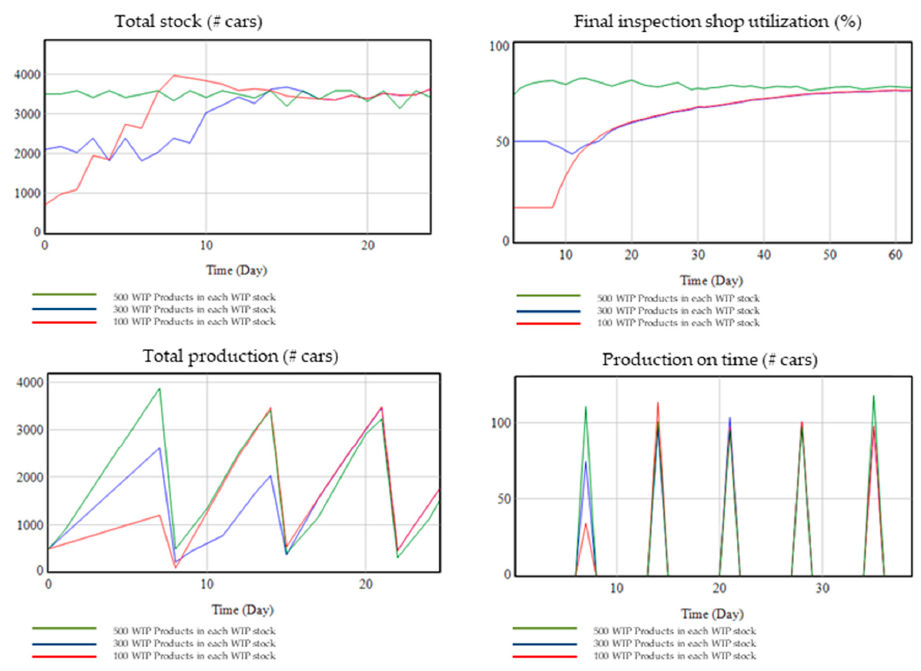
Figure 12. Validation with extreme values: WIP Initial stock.